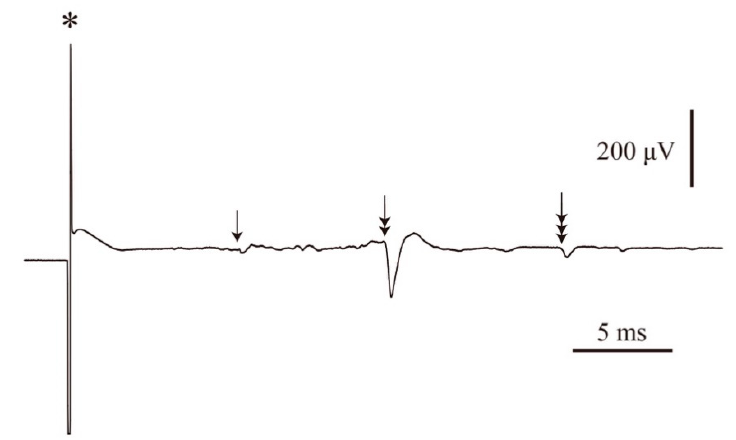
Figure 2. Multiple field potentials of the corticospinal tract (CST) with different conduction velocities. We occasionally observed multiple field potentials in CST neurons with different conduction velocities when applying supra-maximal stimulation to the spinal cord. In this case, the potential with the shortest latency (arrow) is followed by potential with a long latency (double arrow) and then by potential with an extremely long latency (triple arrow). In this case, the conduction velocity of the potential with the longest latency was about 3 m/s. Asterisks indicate stimulus artifacts.